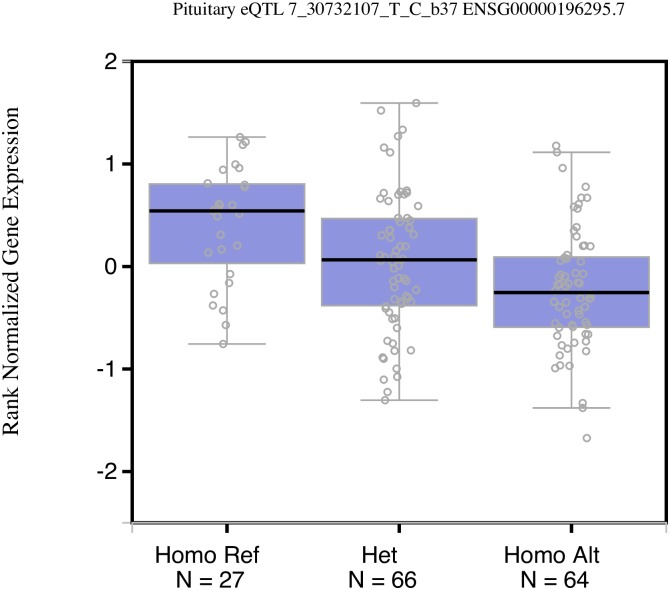
GTEx box plot showing relationships between SNP rs255015 (7_30732107_T_C_b37) genotype and lincRNA AC005154.6 (ENSG00000196295.7) expression in the pituitary (P = 0.000008).The sample groups of the different genotypes are indicated on the X-axis; and the relative expression level of lincRNA AC005154.6 is shown on the Y-axis. The T allele (the reference allele and the ancestral minor allele in the EA population) leads to higher expression of lincRNA AC005154.6. Homo Ref: homozygote for the reference T allele, Het: heterozygote; Homo Alt: homozygote for the alternative allele.